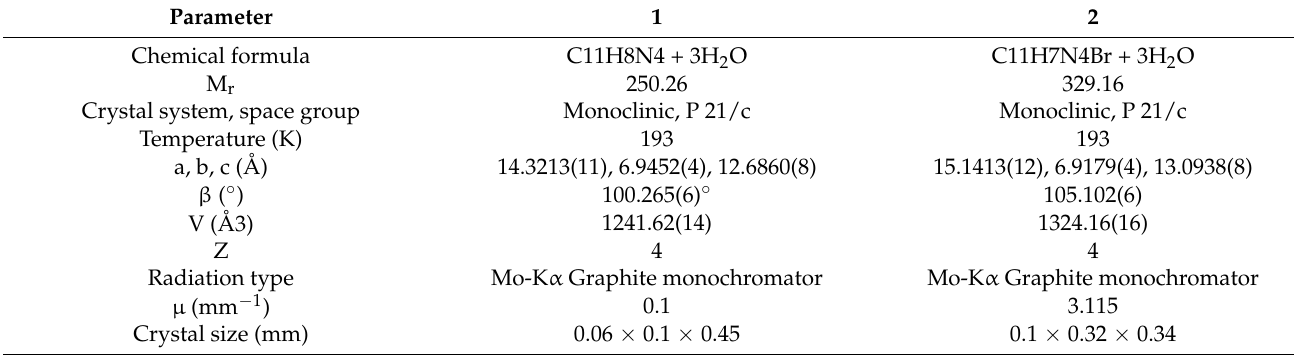
Table 1. Crystal parameters, data collection, and structure refinement details for compounds 1 and 2